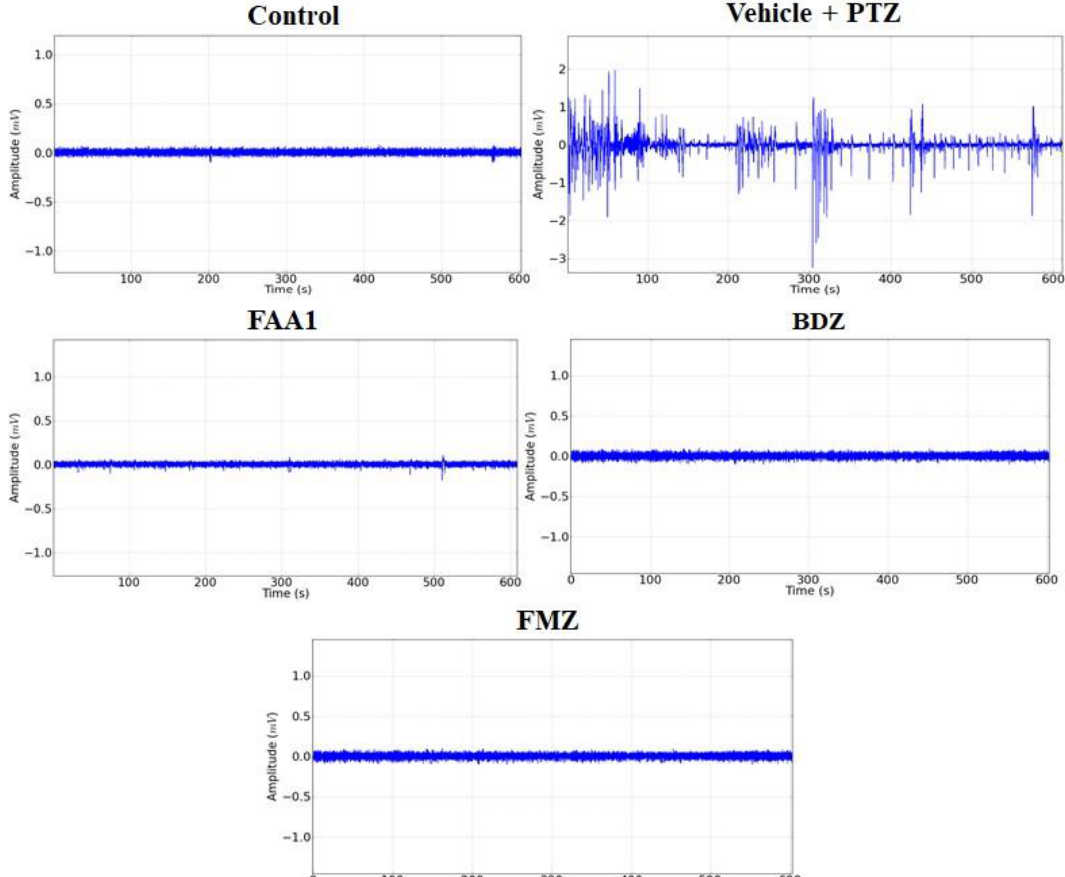
Figure 3. Representative data of electrocorticographic tracing for control, vehicle + PTZ (60 mg/kg), FAA1 (300 mg/kg), BDZ (5 mg/kg) and FMZ (0.1 mg/kg), lasting 600 s.